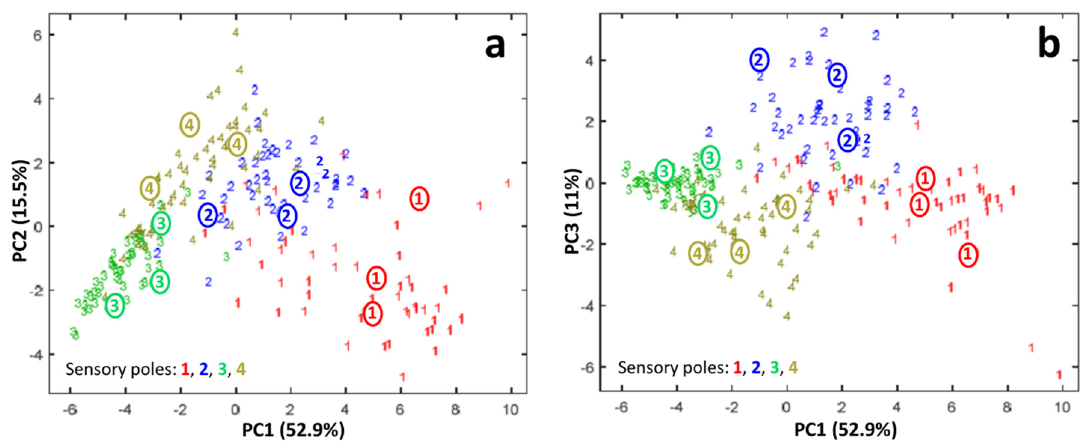
Figure A1. PCA score plots ( a : PC1 vs. PC2 and b : PC1 vs. PC3, respectively) of the 206 chocolates calculated from the average intensities of 36 flavor attributes determined by quantitative descriptive analysis. The data were normalized by the sum of the intensities. For illustrative purposes, the colored numbers correspond to the four different sensory poles. The twelve samples under investigation (three in each pole) are circled.